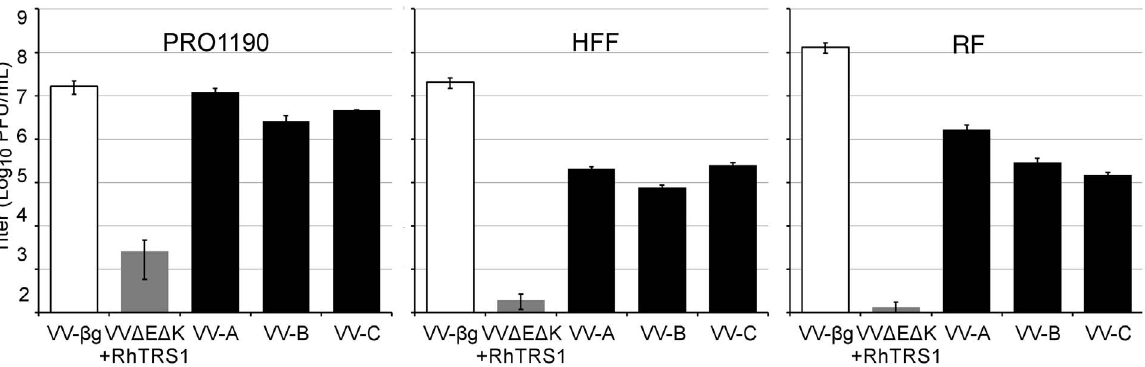
Figure 3. Adaptation in minimally-permissive PRO1190 cells expands the species tropism of VV D E D K + RhTRS1. PRO1190 (left), HFF (center), or RF (right) were infected with the indicated viruses (MOI=0.1). Lysates were harvested 48 hpi and titered on BSC40 cells. Data are represented as means + 1 STD.